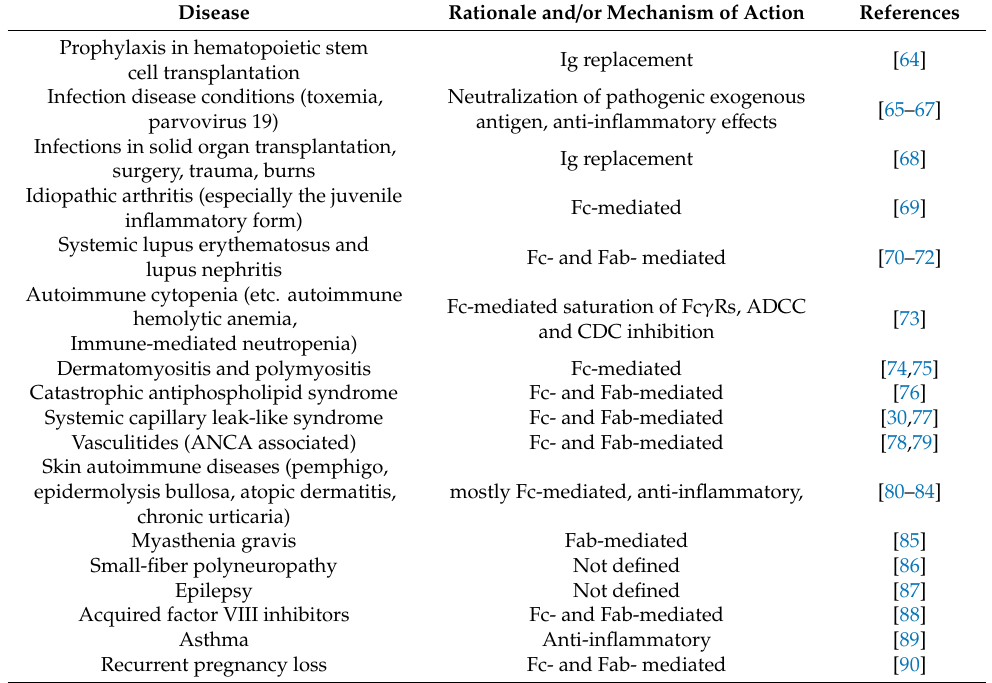
Table 2. Diseases considered for the off-label use of intravenous human normal immunoglobulin (IVIG).